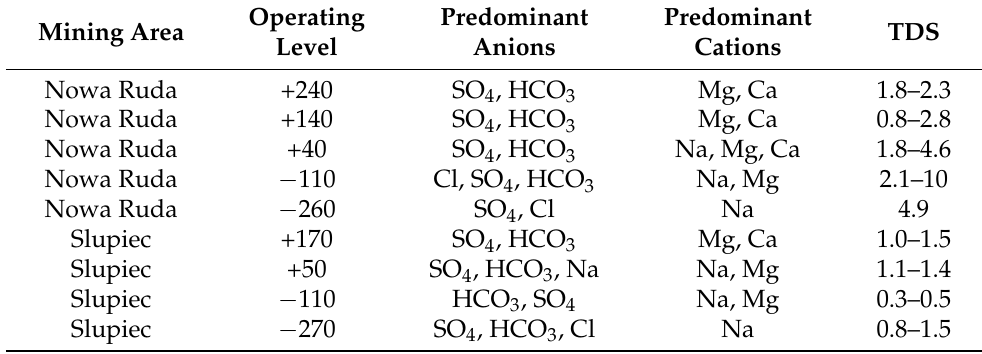
Table 4. Simplified chemical composition of waters in the vertical profile (TDS in g/L)